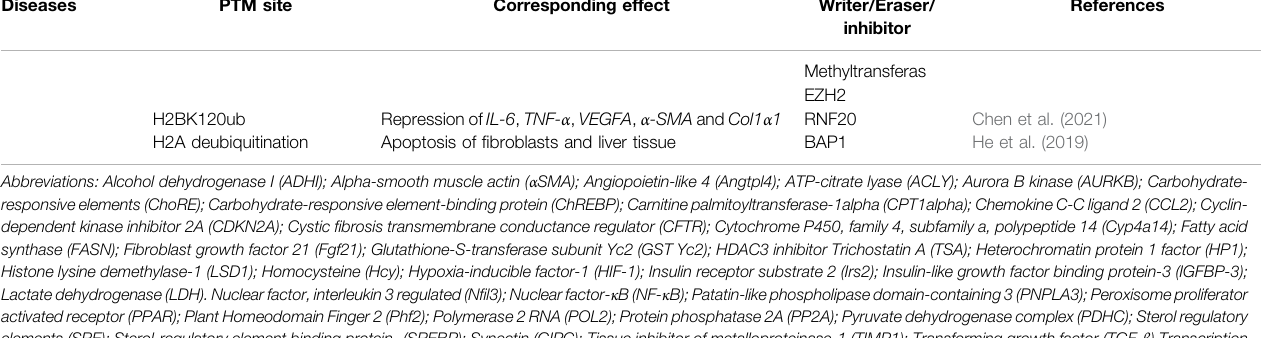
Frontiers in Pharmacology |